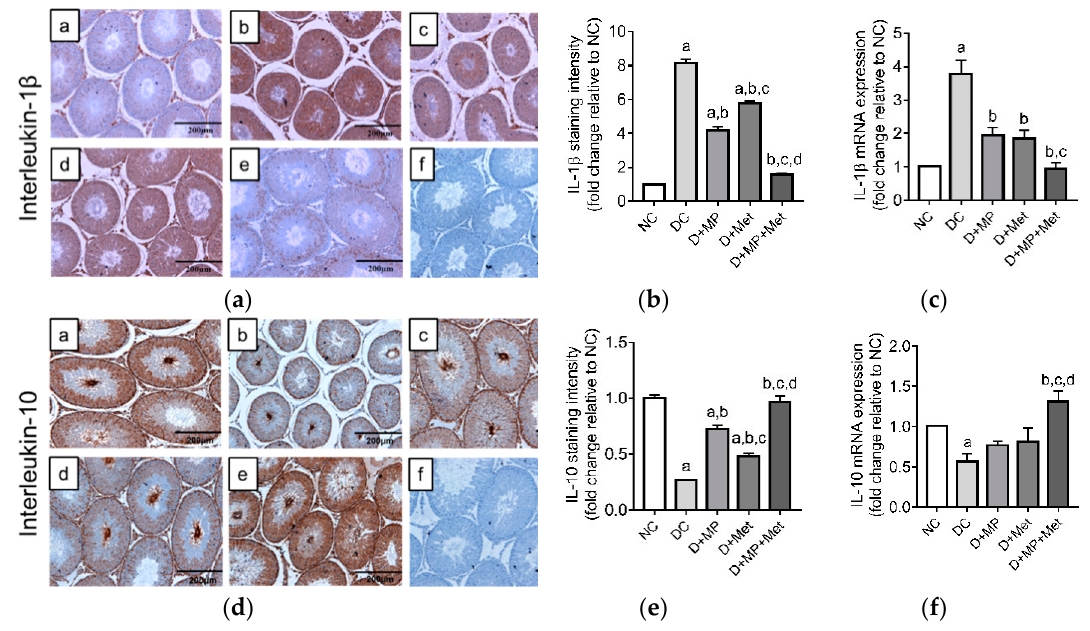
Figure 6. Expression of interleukin ‐ 1 β protein ( a , b ) and mRNA ( c ), and interleukin ‐ 10 protein ( d , e ) and mRNA ( f ) in the testes of ( a ) NC, ( b ) DC, ( c ) D+MP, ( d ) D+Met and ( e ) D+MP+Met groups. For each biological replicate, a negative control was included in which phosphate buffered saline was substituted for the primary antibody. A representative photomicrograph of the negative control is shown as ( f ) (magnification = ×100, scale bar = 200 μ m). For quantitative data, values are expressed as mean ± SD, n = 8 (for staining intensity) and n = 6 (for mRNA expression). a p < 0.05 versus NC, b p < 0.05 versus DC, c p < 0.05 versus D+MP, d p < 0.05 versus D+Met (one ‐ way ANOVA followed by Tukey’s post ‐ hoc test). NC: normoglycaemic control, DC: diabetic control, D+MP: diabetic rats treated with Malaysian propolis, D+Met: diabetic rats treated with metformin, D+MP+Met: diabetic rats treated with Malaysian propolis + metformin, IL: interleukin.